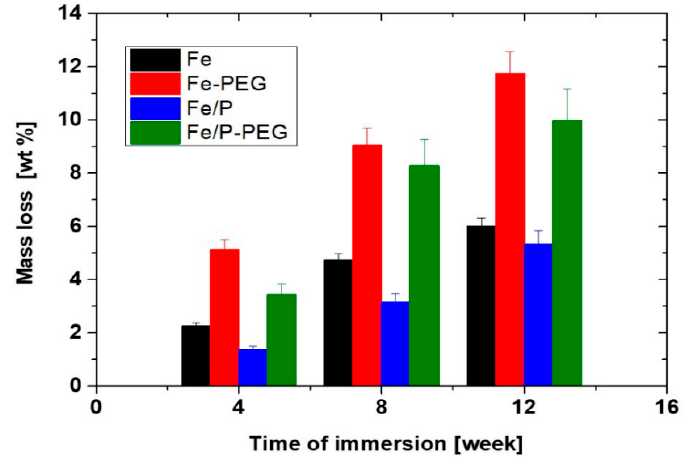
Figure 3. Mass losses during immersion in Hanks’ solution for 4, 8, and 12 weeks for iron-based foams (Fe, Fe-PEG, Fe/P, and Fe/P-PEG).